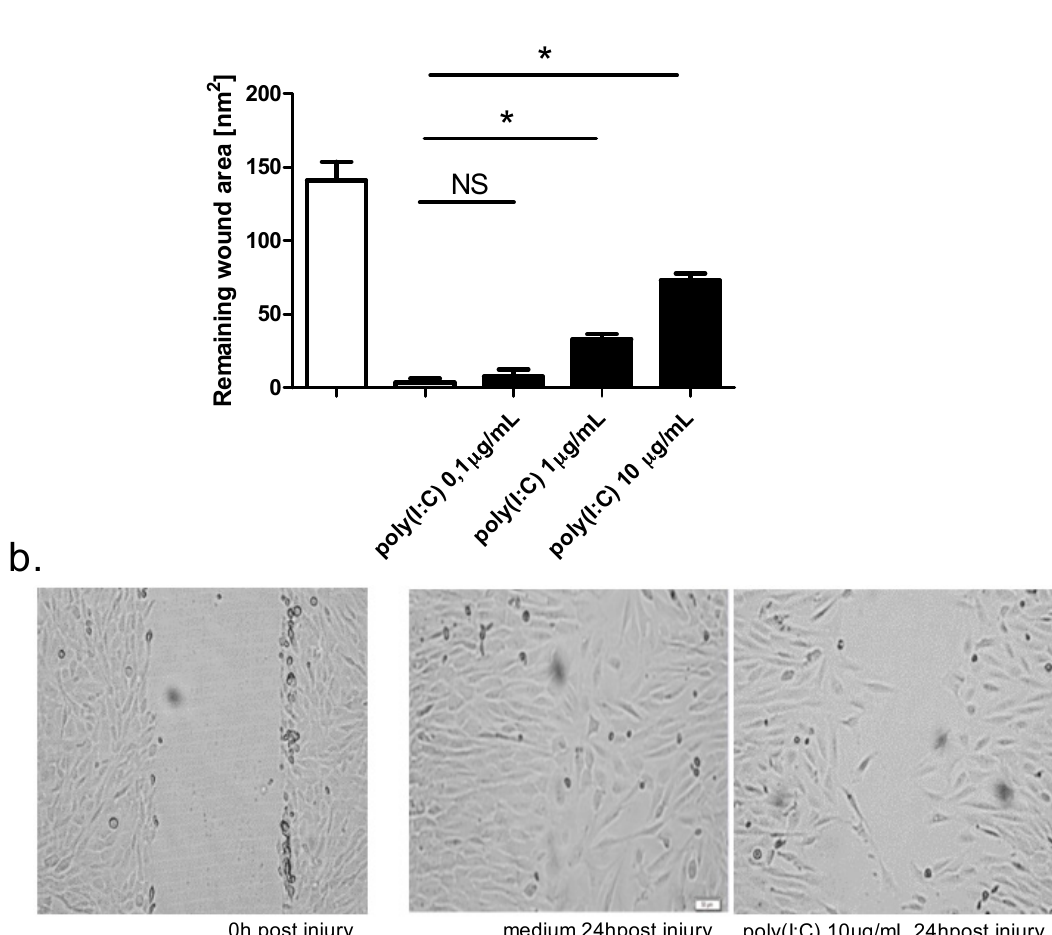
Figure 2. Effect of TLR agonist poly(I:C) on wound repair in BEAS-2B ( n = 8), 24 h post injury. ( a ) Concentration dependent effect of poly(I:C) on wound repair in BEAS-B cultures, remaining wound area was measured 24 h post injury 2; ( b ) Representative images of injured BEAS-2B cells 0 h and 24 h post injury with or without poly(I:C) (10 µ g/mL). NS, no statistically significant difference. The magnification is 100 × ; * p < 0.05 .